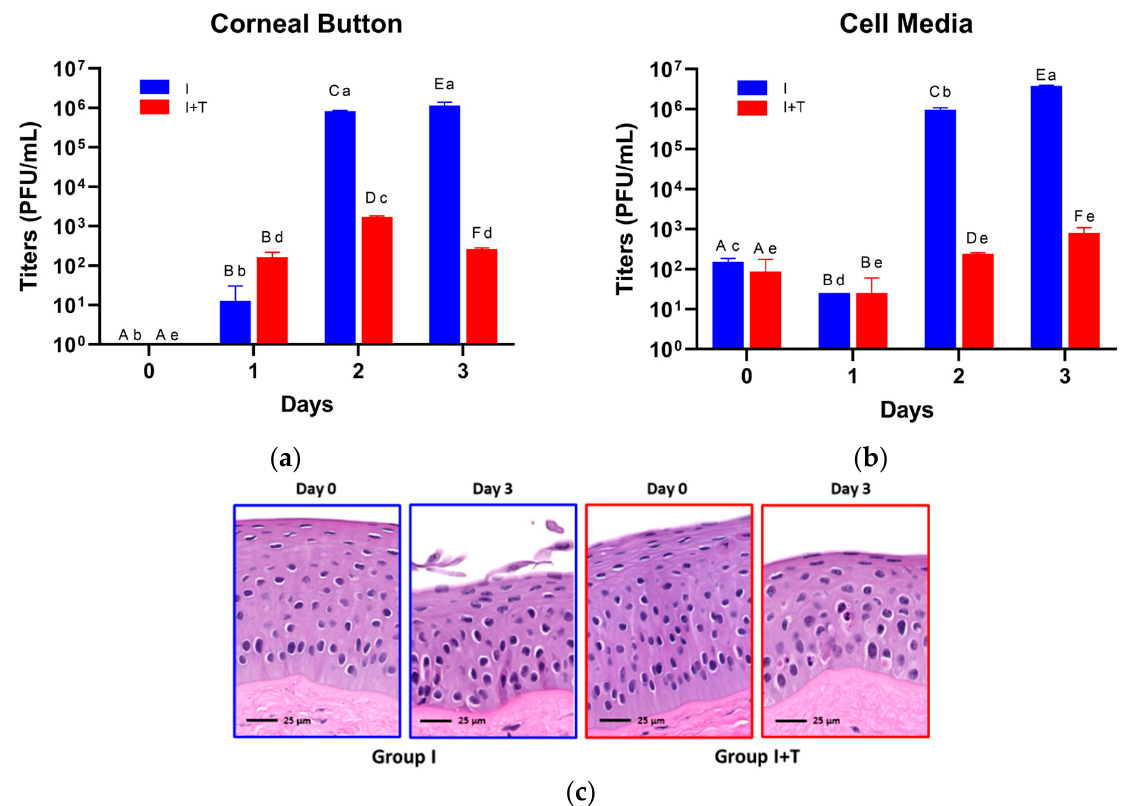
Figure 4. Homogenized corneal button ( a ) and liquid EpiLife ® cell media ( b ) BoHV-1 titers for ex vivo bovine corneal culture. I = BoHV-1-infected, untreated group; I+T = BoHV-1-infected, cidofovir-treated group. Columns connected by the same letter labels are not significantly different ( p > 0.05). Uppercase letters correspond to within-day comparisons. Lowercase letters correspond to within-treatment comparisons. ( c ) Representative photomicrographs from histologic specimens of the I and I+T groups on days 0 and 3 depicting corneal epithelial changes over the duration of culture. In the I group, attenuation of the epithelium with cellular condensation, disorganization of epithelial stratification, heterogenous nuclear chromatin, and exfoliation of the squamous epithelium are seen on day 3. In the I+T group, attenuation of the epithelium, cellular condensation, and multiple eosinophilic cytoplasmic inclusions (suggesting cell death) are seen.